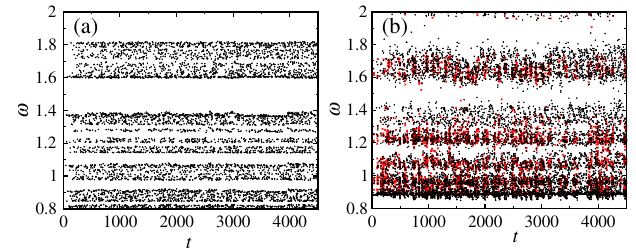
FIG. 10. Phase slips for g ¼ 1 [panel (a)] and g ¼ 1 . 3 [panel (b)] for N ¼ 4000 . Black circles correspond to forward slips; red crosses correspond to backward slips, occurring only in panel (b).